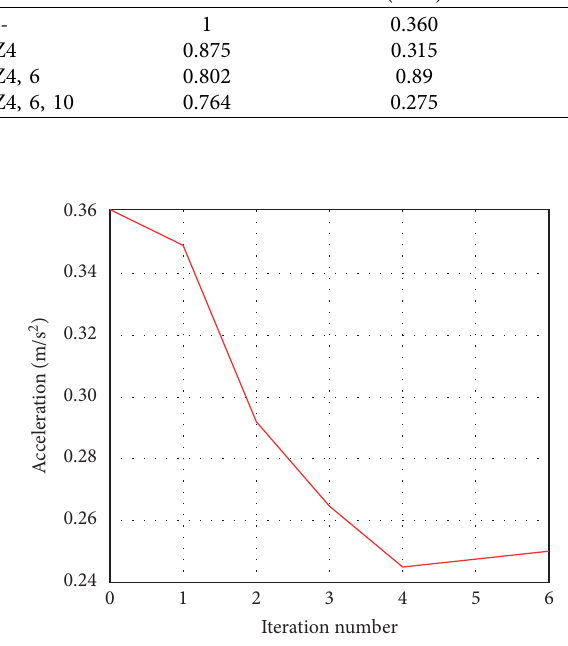
Figure 24: Iteration of vertex peak